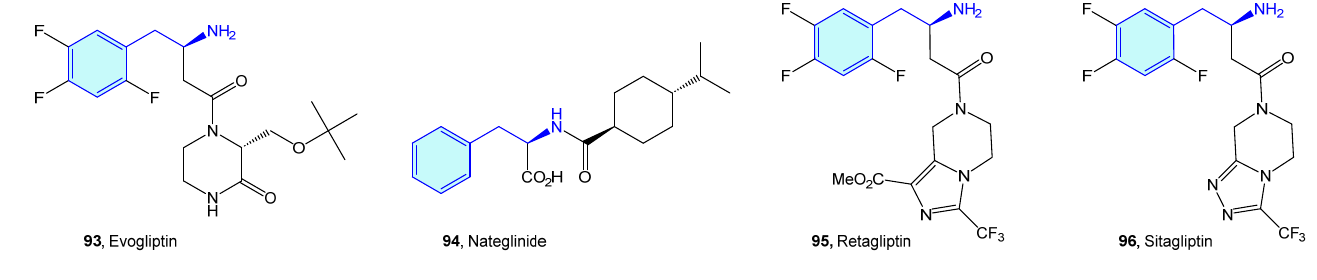
Figure 10 . 2-Phenylethyl-based DPP4 medicinal chemistry leads. Figure 10. 2‑Phenylethyl‑based DPP4 medicinal chemistry leads. Table 3. DPP4 medicinal chemistry leads.